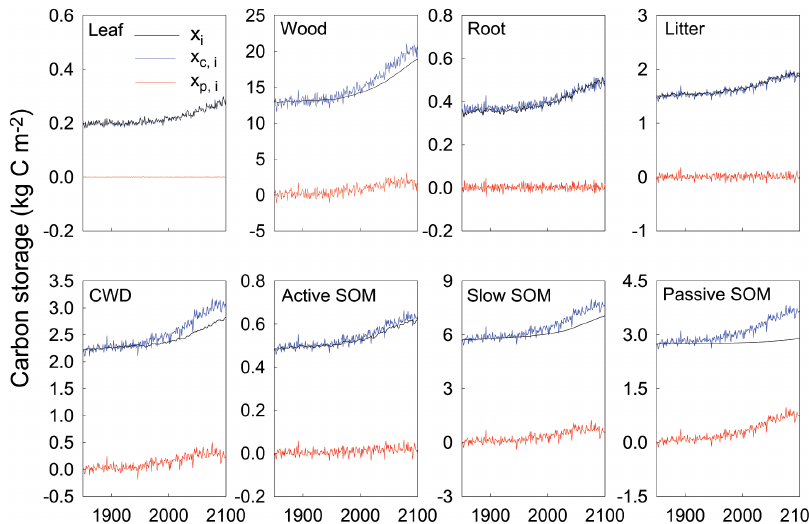
Figure 6. The C storage capacity ( x c ,i (t)) , the C storage potential ( x p ,i (t)) , and C storage ( x i (t)) of individual pools. The potential is nearly zero for those fast turnover pools with short residence times but very large for those pools with long residence times.